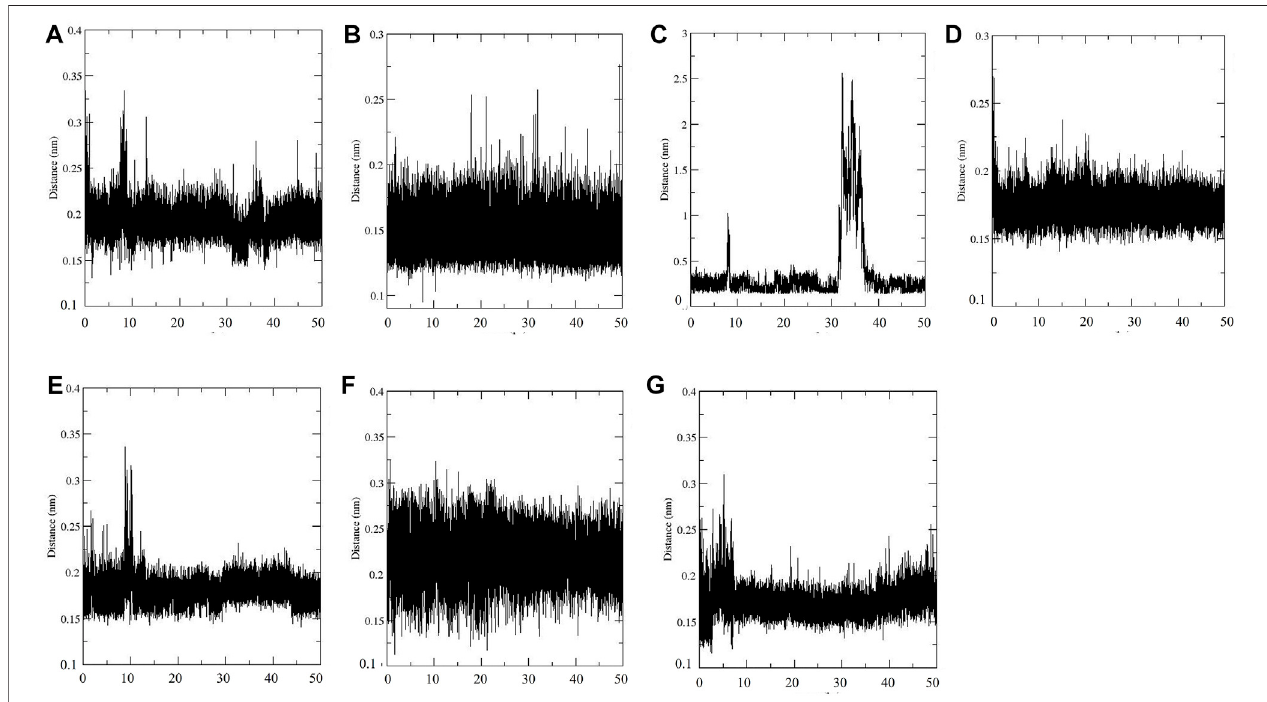
FIGURE 4 | Min distance between SENP2 and compounds (A) GA, (B) CA, (C) TQ, (D) Betanin, (E) Betanidin, (F) Ebselen, and (G) Fisetin.